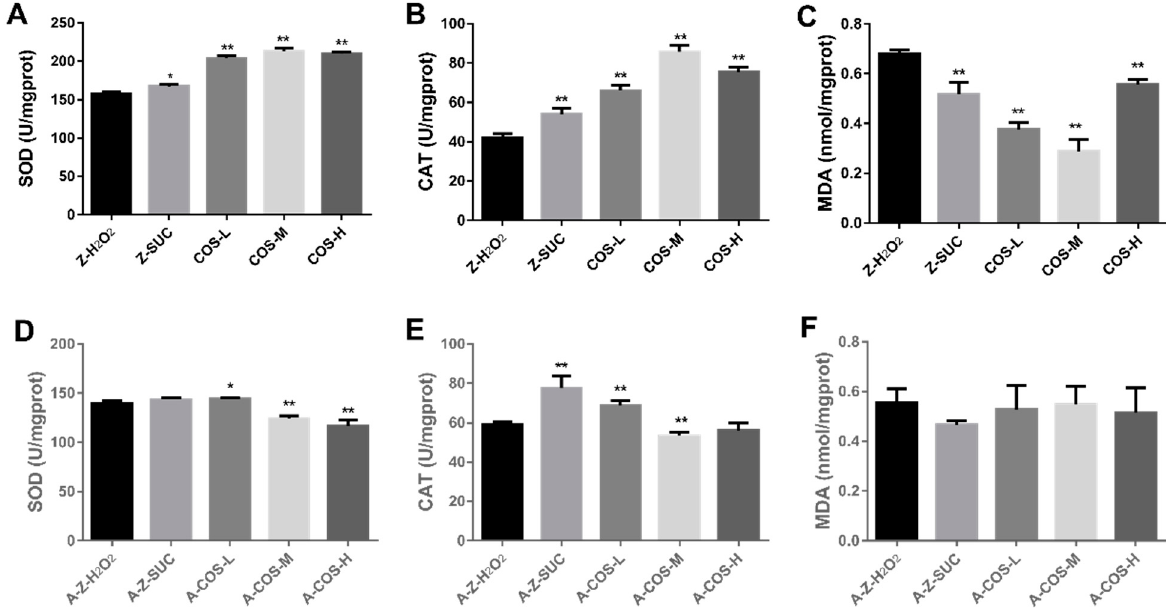
Figure 3. Effects of COS on SOD ( A , D ), CAT ( B , E ) and MDA ( C , F ) levels in female Drosophila . Charts ( A – C ) present the results of normal fruit flies, and ( D – F ) present the results of axenic fruit flies. Differences among treatments were obtained with one-way analysis of variance followed by Tukey’s multiple comparisons test. When compared with the H 2 O 2 treated group, * and ** represent p < 0.05 and p < 0.01 respectively.